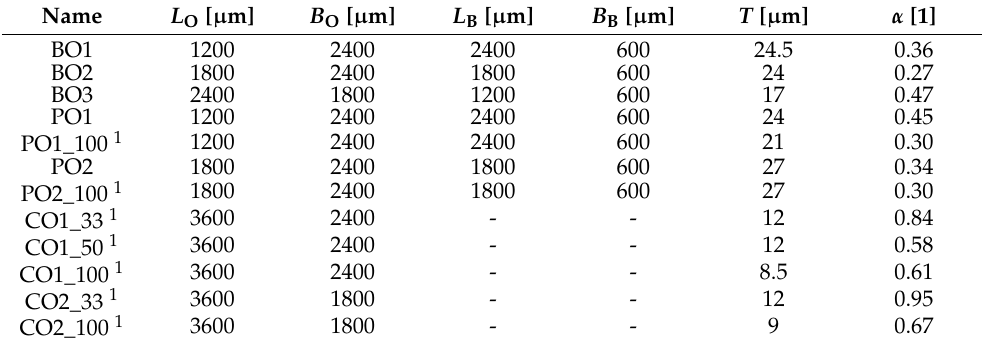
Table 1. Listing of all investigated MEMS oscillator geometries and their dimensions. The thickness T is obtained from numerical simulations and the scale factor α is determined by applying best fit method of Equation (3) to resonance frequency plot shown in Figure 5. The Young’s modulus E Si = 130 GPa and density ρ S i = 2.330 g/cm 3 are taken from